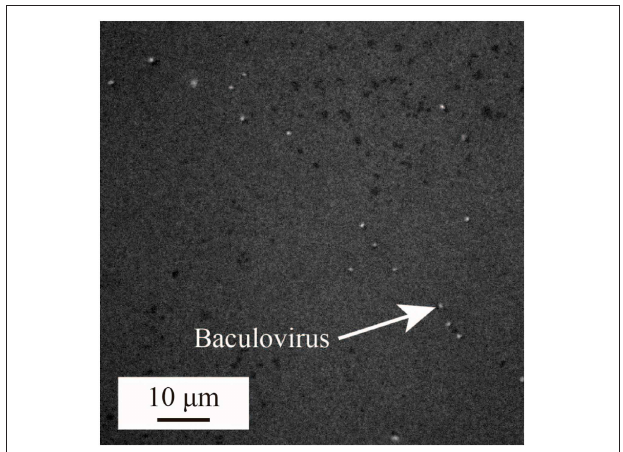
FIGURE 1 | Scanning electron microscopy of baculovirus used for counting the number of